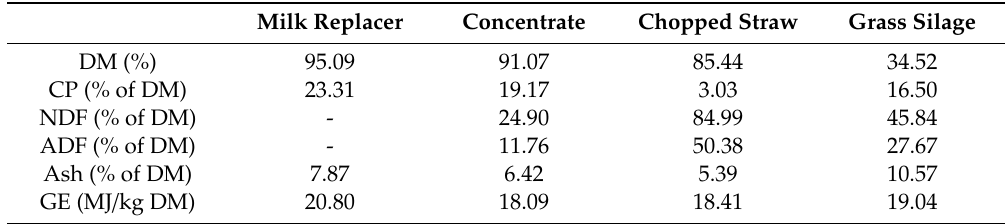
Table 3. Chemical composition of milk replacer, concentrate, chopped straw and grass silage o ff ered to calves throughout the experimental